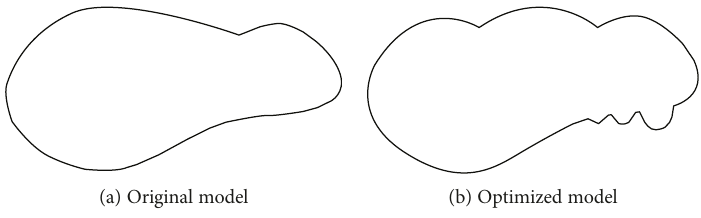
Figure 7: Original and optimized asymmetric cross-section